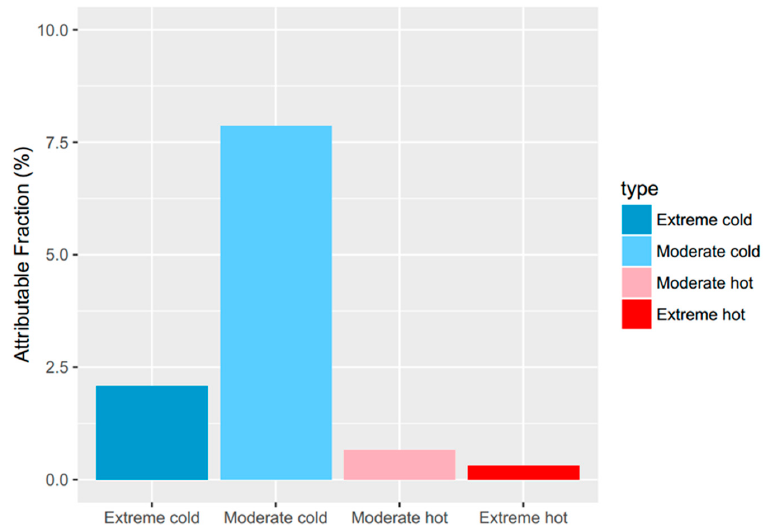
Figure 5. Fraction of non-accidental mortality attributable to moderate and extreme hot and cold temperature.